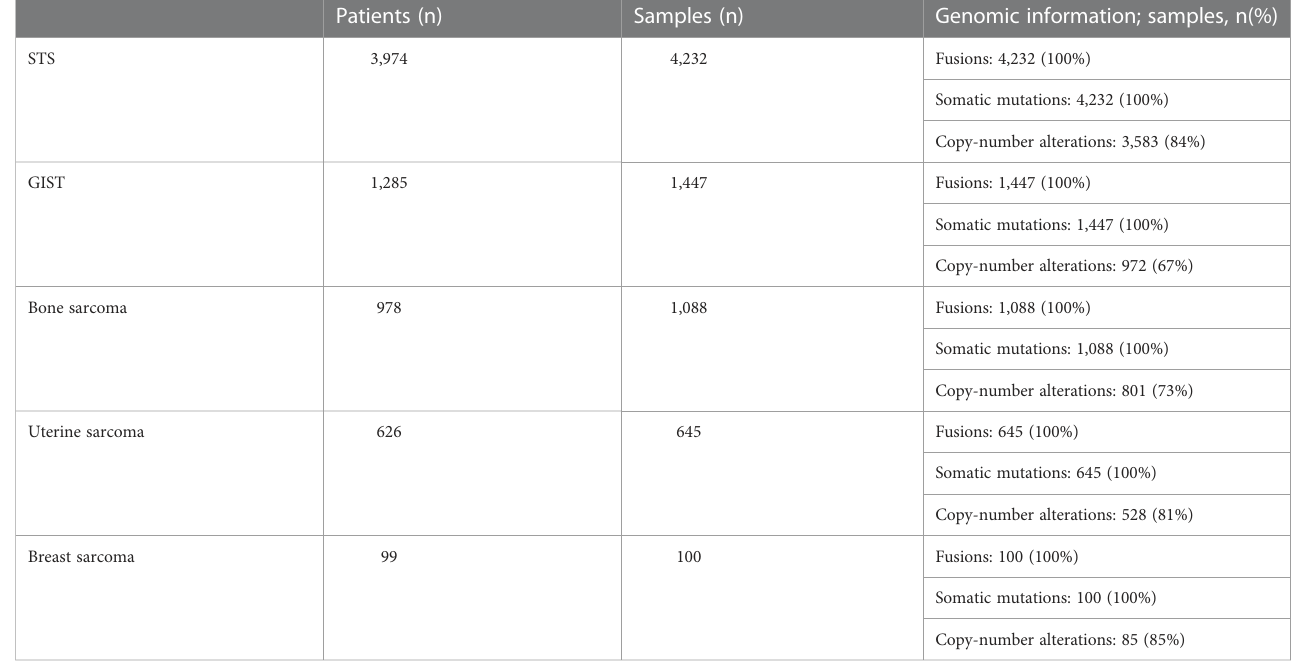
TABLE 1 Number of patients, samples, and genomic information for each